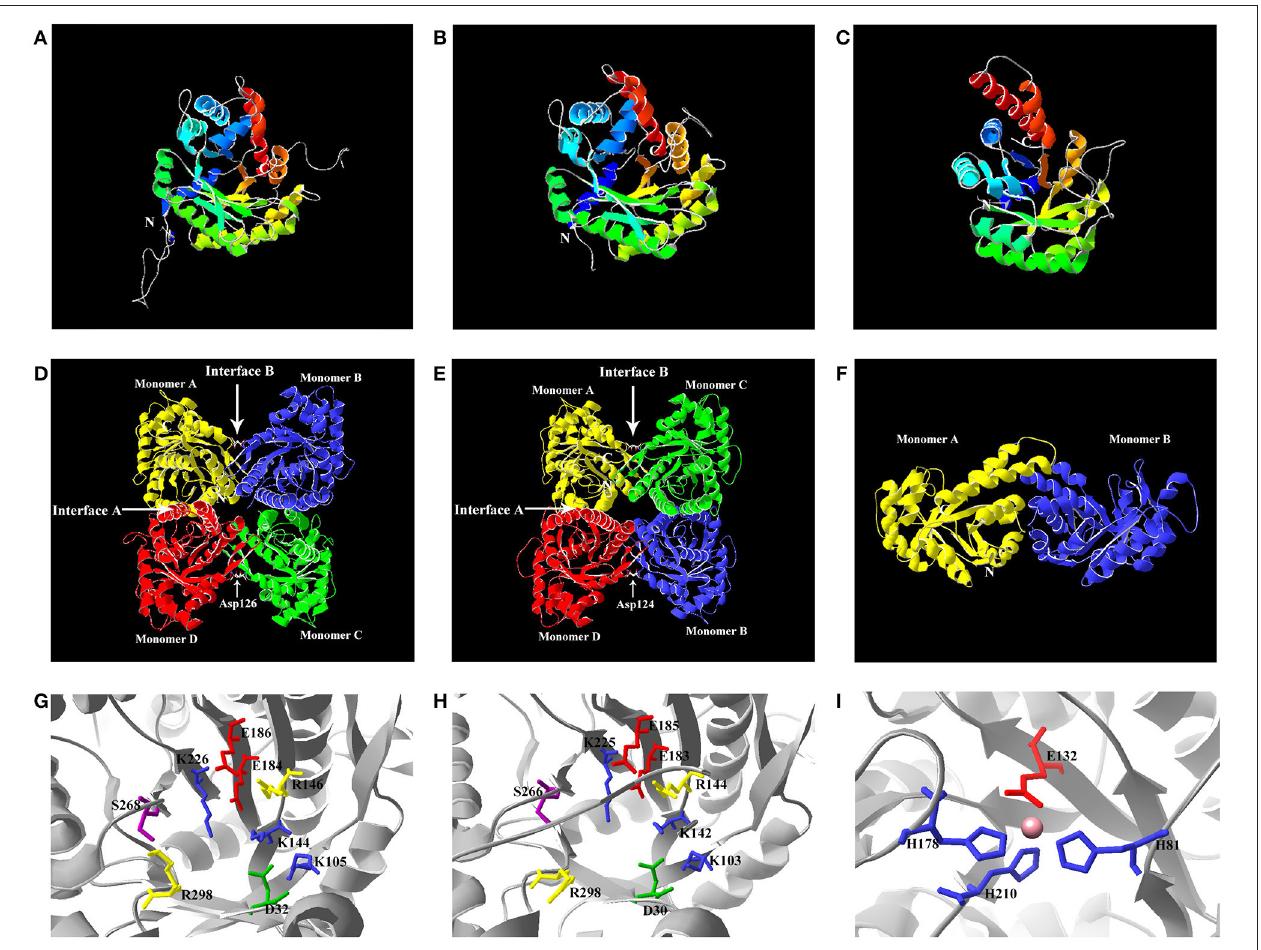
FIGURE 4 | Predicted structures of TaFBA protein monomers and homo-oligomers. (A) Monomer TaFBA4. (B) Monomer TaFBA10. (C) Monomer TaFBA20. The C- and N-termini are labeled for monomer. (D) Tetrameric TaFBA4. (E) Tetrameric TaFBA10. (F) Dimeric TaFBA20. (G) Active site residues of TaFBA4. (H) Active site residues of TaFBA10. (I) Active site residues of TaFBA20. For (A–F) , Each monomer is colored separately, and A and B interfaces are indicated by arrows. The sites of the Asp126/124 substitutions are indicated on interface B, the C- and the N-termini are labeled for monomer A. The active site residues involved in substrate binding and catalysis are shown in different colours. For (G–I) , Lys226/225 (G,H) situated at the centre of the active region responsible for Schiff base formation, the filled circle of represents divalent metal cation in the three open protomers of